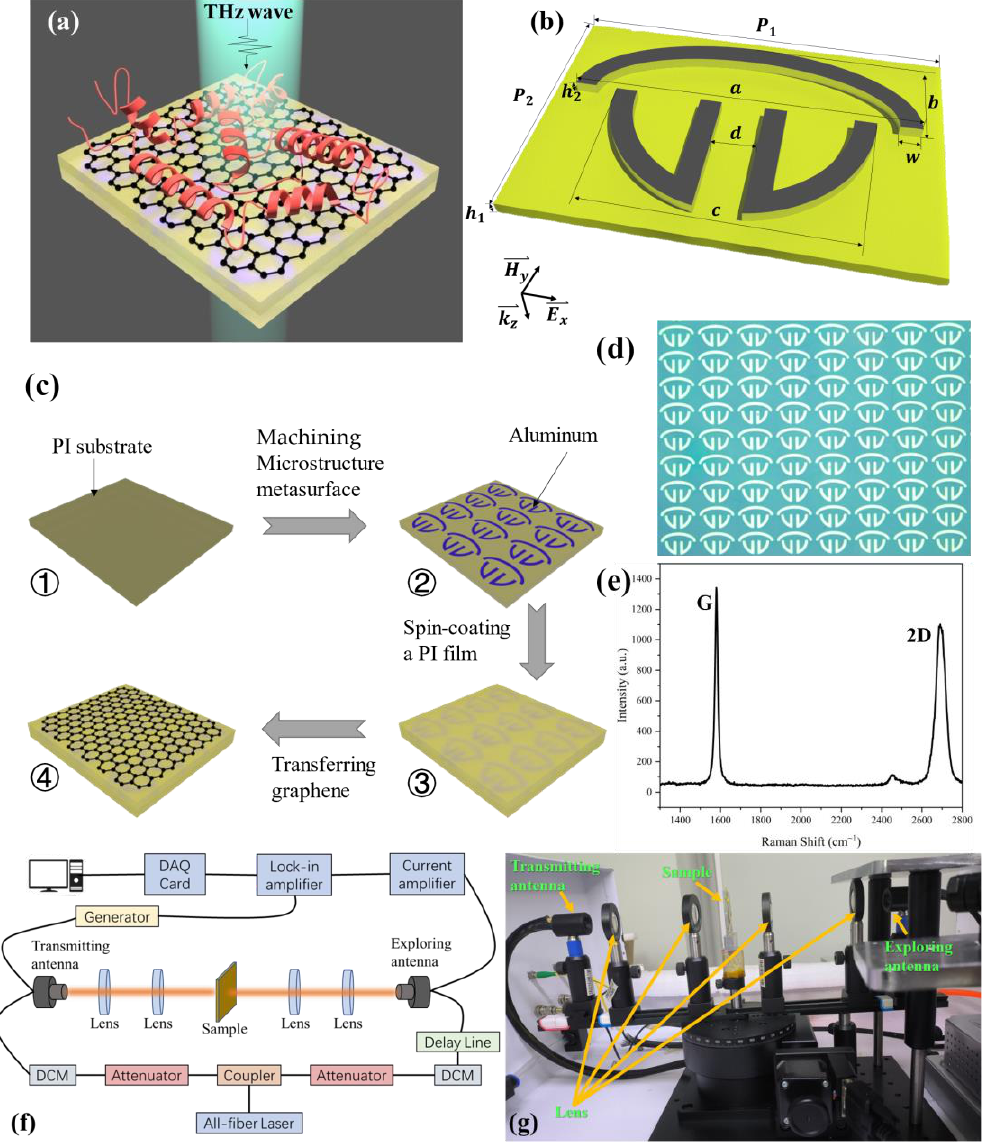
Figure 1. ( a ) Schematic of biosensor structure. ( b ) Schematic of MM structure and geometric parameters: P 1 = 162 µ m, P 2 = 108 µ m, h 1 = 15 µ m, h 2 = 0.2 µ m, a = 144 µ m, b = 36 µ m, c = 108 µ m, d = 18 µ m, w = 9 µ m. ( c ) Fabrication of the proposed biosensor. ( d ) Micrograph of fabricated biosensor sample. ( e ) Raman spectra of three-layer graphene were measured with a 514 nm excitation laser. ( f ) The schematic view of the all-fiber THz-TDS measurement setup. ( g ) Experimental photoelectric